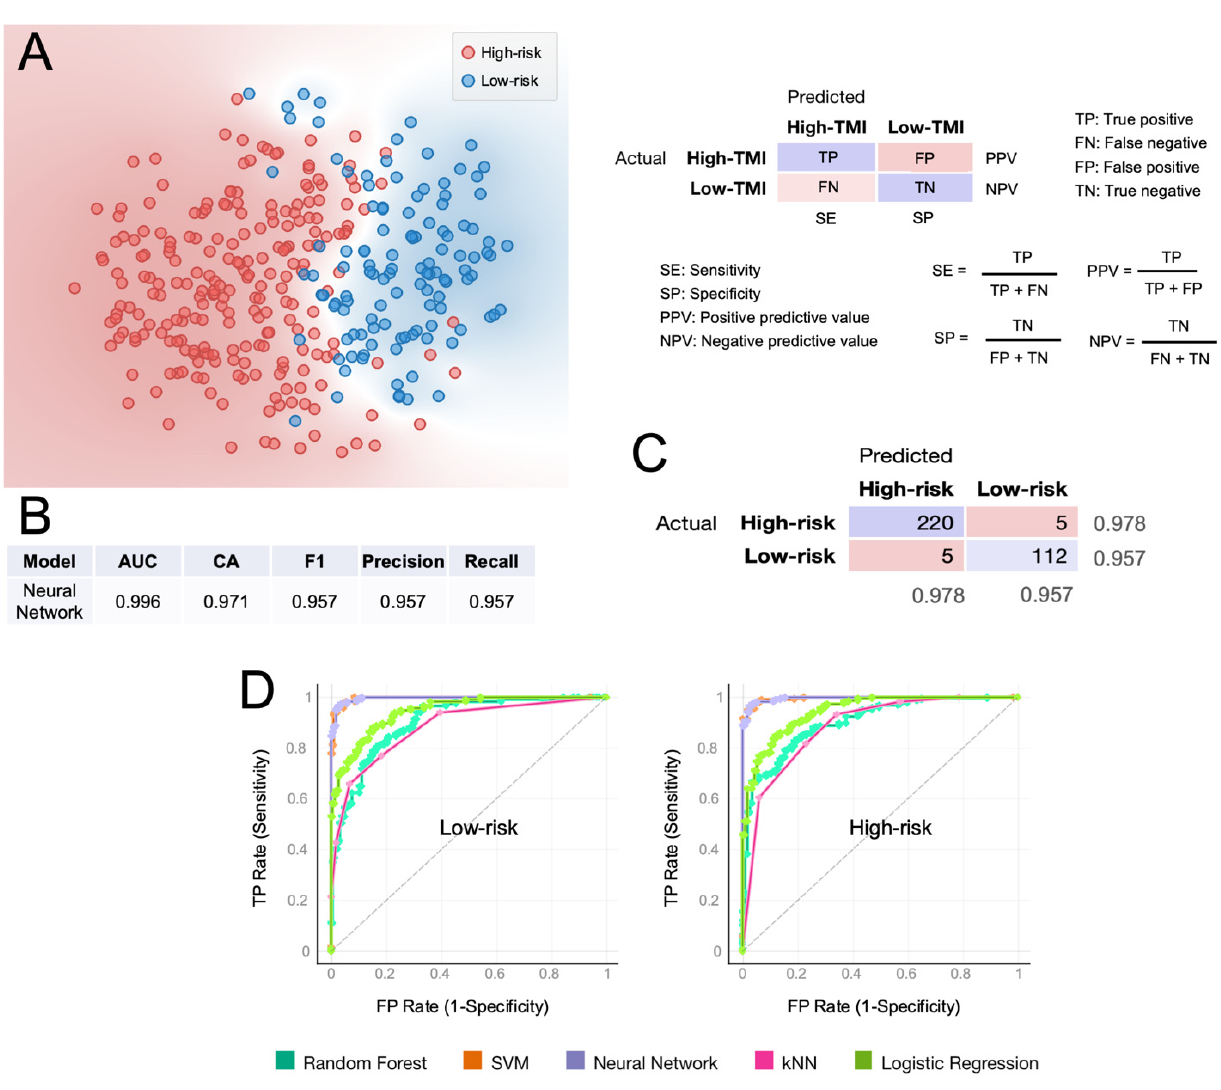
Figure 5. Computational classification of the HGSOC-TMI risk group at the patient level. ( A ) A t-SNE plot of two risk groups for the training set (TCGA). ( B ) Results of the classification model evaluation using 10-fold cross-validation. ( C ) Confusion matrix of the neural-network model, which had the best scored in the classification. ( D ) Receiver operating characteristic (ROC) curves for two HGSOC-TMI risk groups. AUC = area under the curve. CA = classification accuracy.